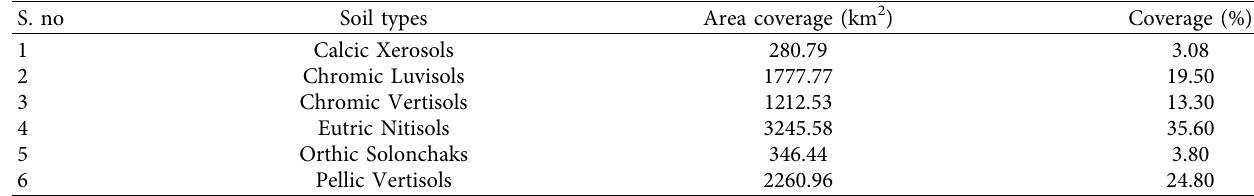
Table 3: Soil types of the study area.